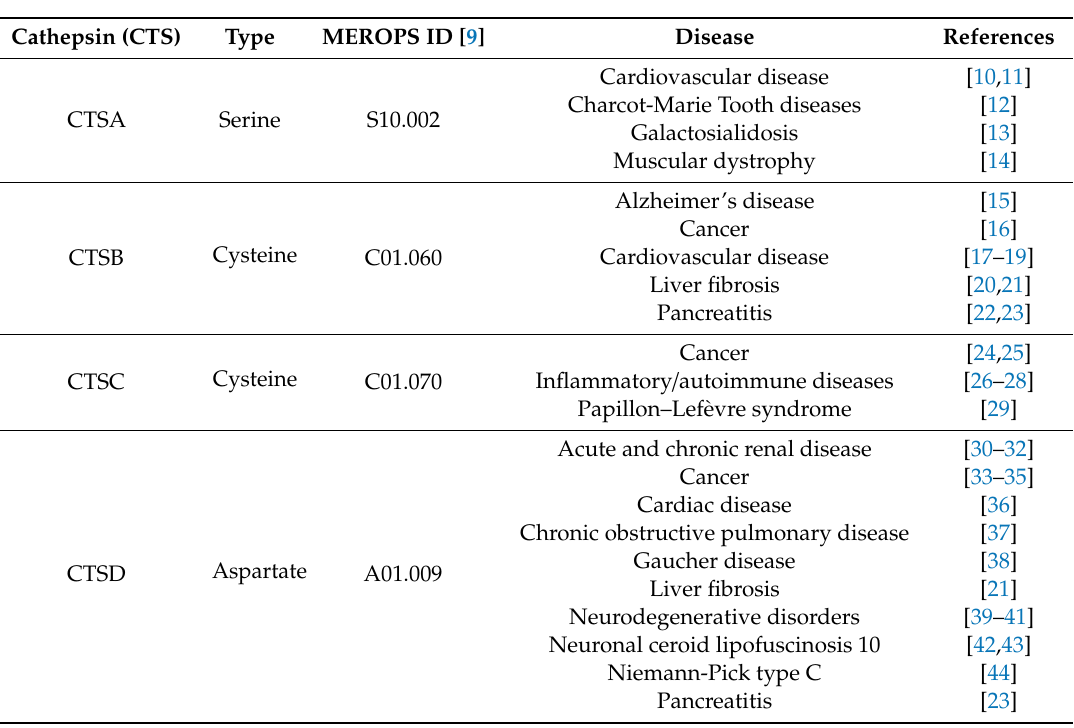
Table 1. Cathepsin-related diseases.